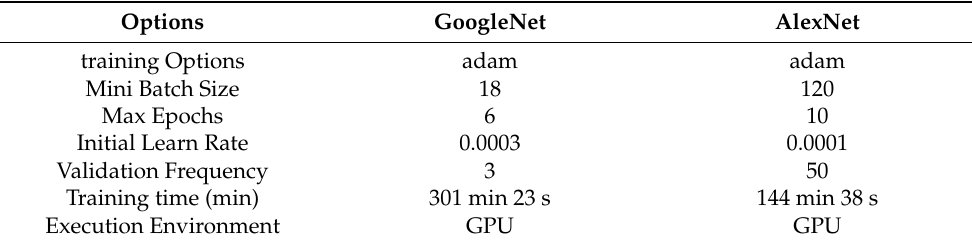
Table 4. Seting parameter options for GoogLeNet and AlexNet models.